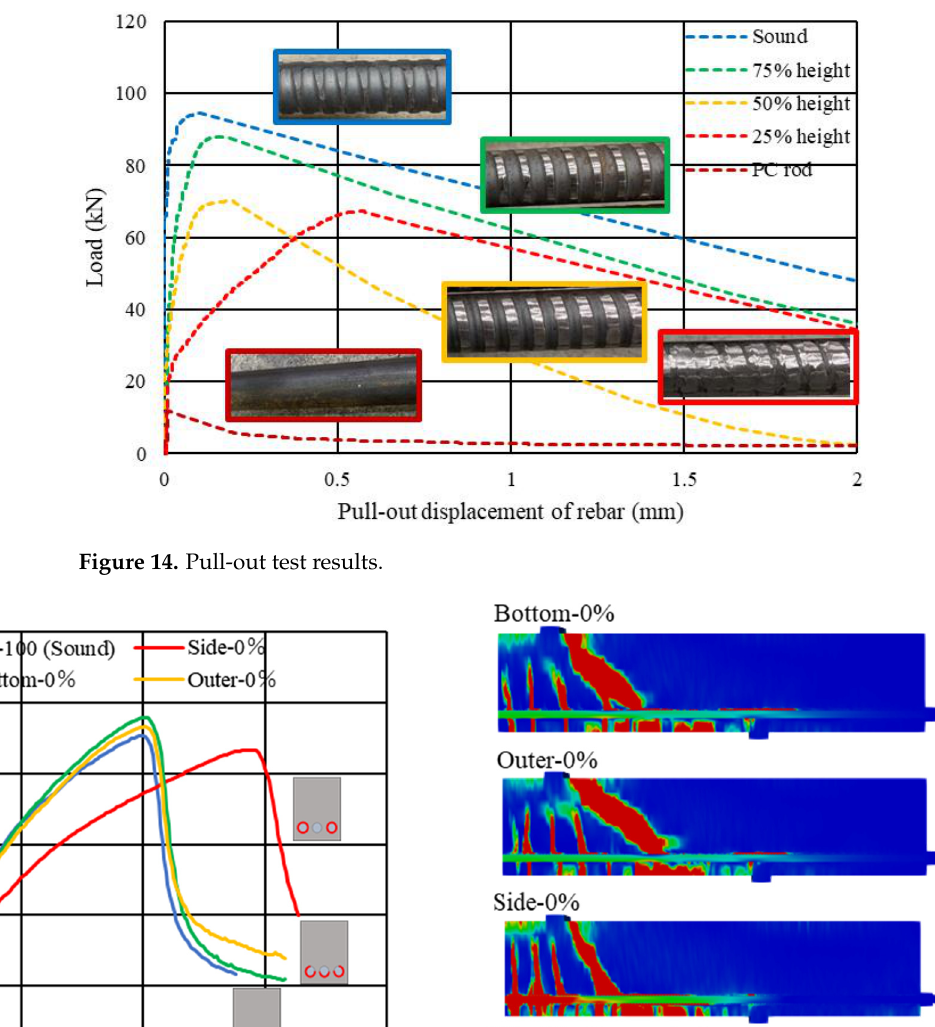
Figure 16. Analysis results (effect of non-uniform lug loss in axial direction of rebar). Figure 17 shows the distribution of flexural cracks before shear crack formation in LugInt-3.5 cm and LugInt-7 cm. The orange parts indicate the sound lug zones, and almost of all flexural cracks occur from sound lug zones or at the boundary between a sound lug zone and a lug loss zone. These parts are considered when there was strong bond between